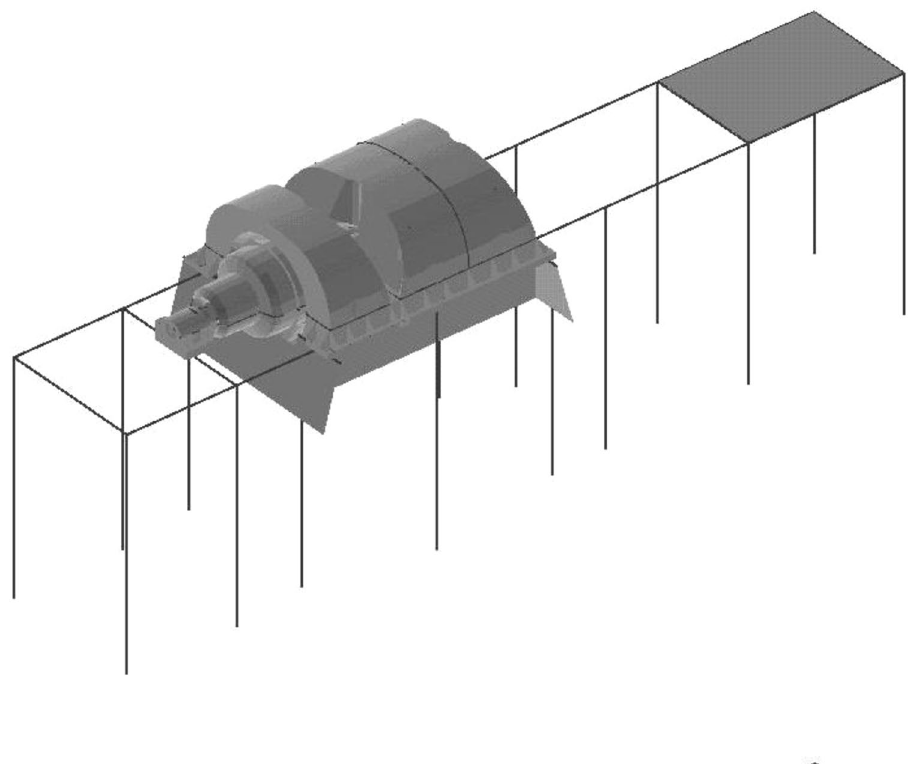
Fig. 3 Computational basic model 10 with a low degree of